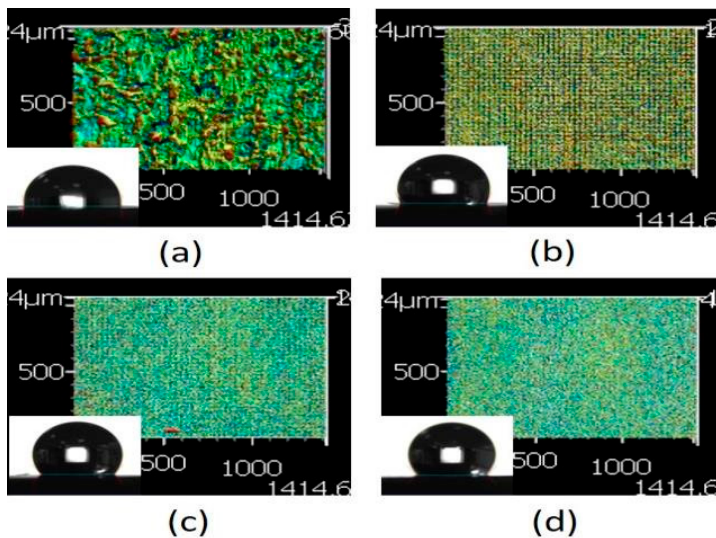
Figure 8. 3D images of the XO RGP contact lens treated with the laser system with line pitches of (a) 30 μ m and a scanning speed of ( a ) 500, ( b ) 1000, ( c ) 1500, and ( d ) 2000 mm/s.